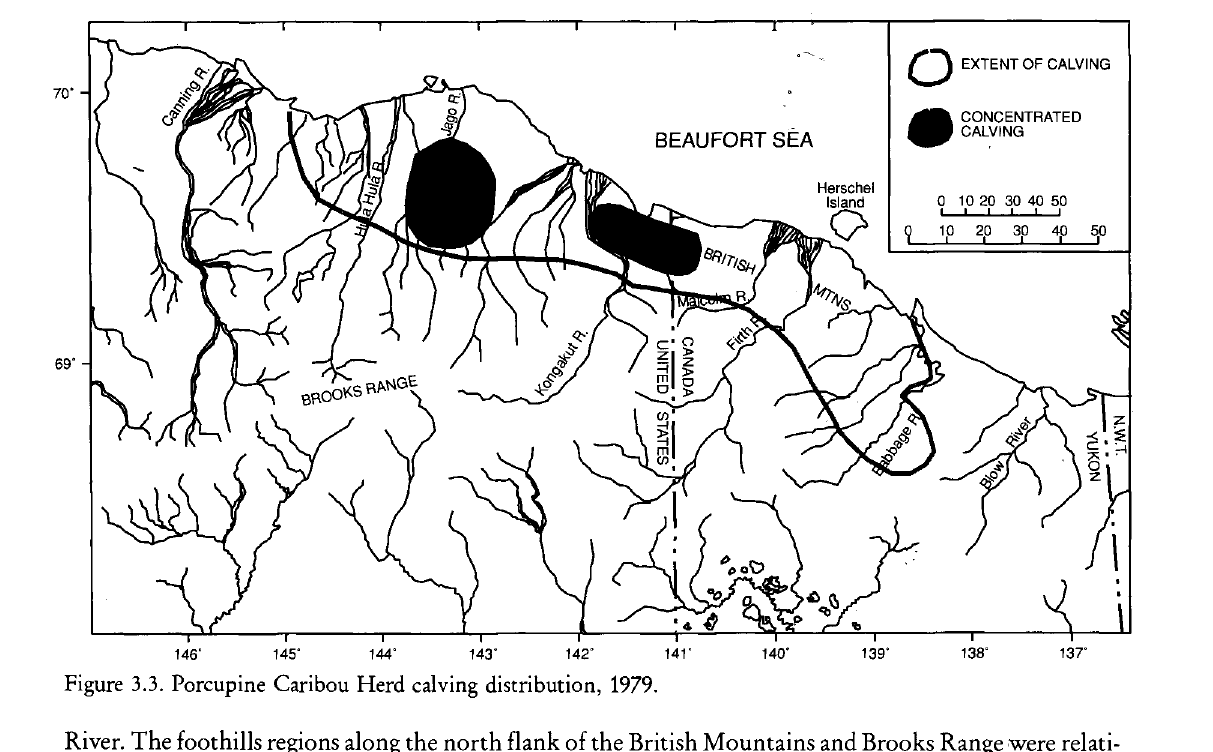
Figure 3.3. Porcupine Caribou Herd calving distribution, 1979. River. The foothills regions along the north flank of the British Mountains and Brooks Range were relati vely free of snow. The extent of calving corresponded closely to the snowfree areas, farther south and east than the usual concentration areas (Russell et al. 1992b). Areas of significant calving included the foothills reaches of the Trail, Crow, Spring and Firth Rivers, across the Fish Creek-Clarence River coastal